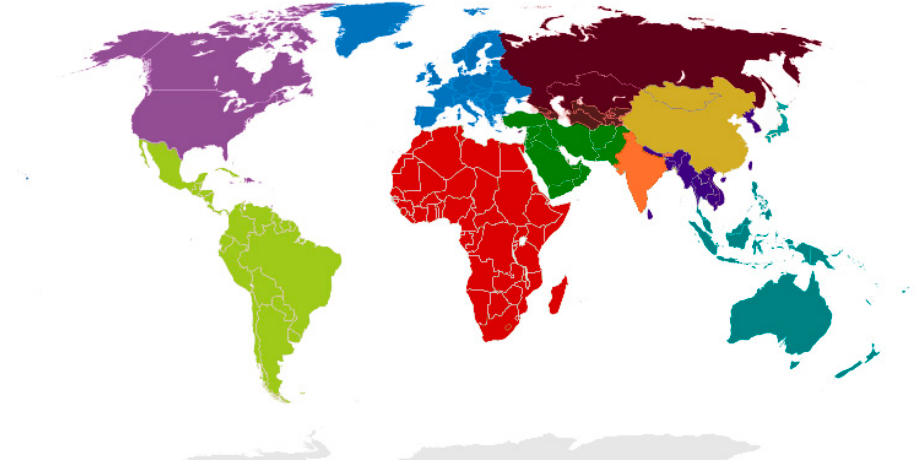
Figure 3. Regional disaggregation of GENeSYS-MOD.